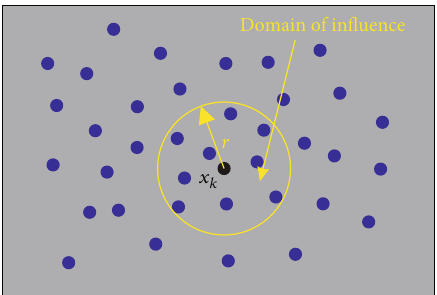
Figure 2: Schematic of domain of in fl